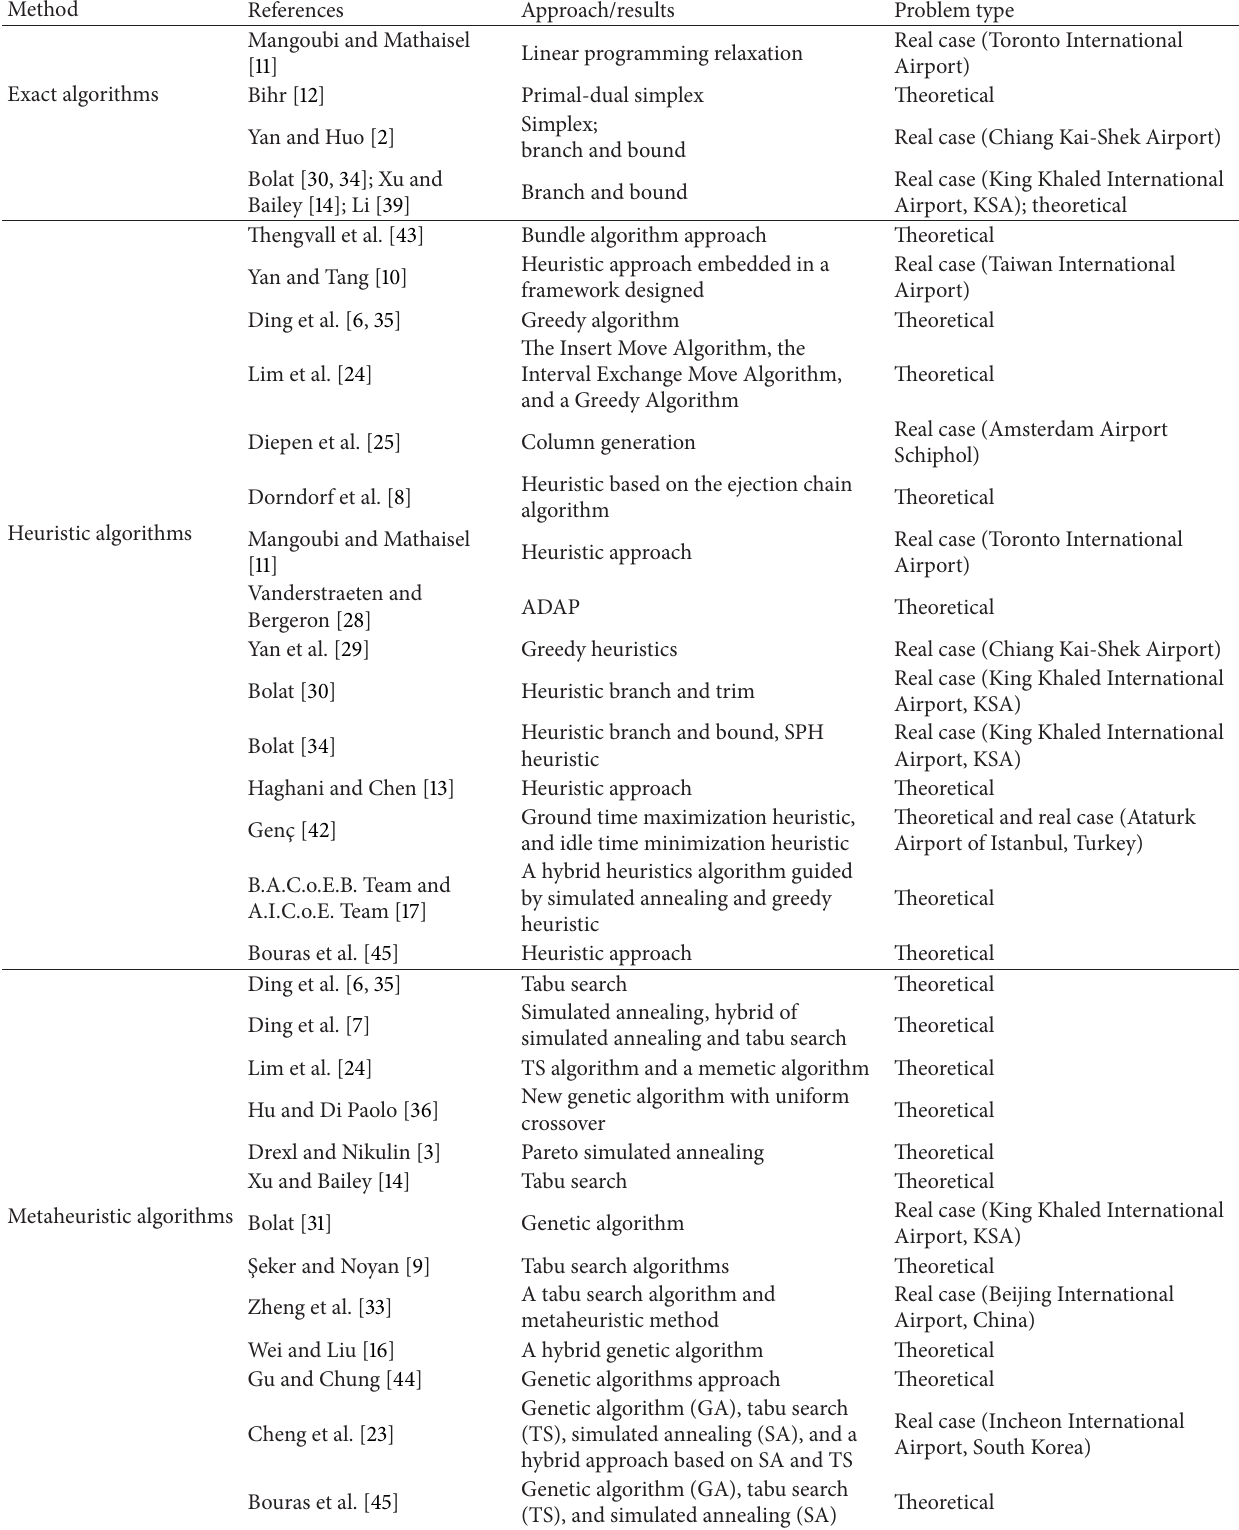
Table 2: Resolution